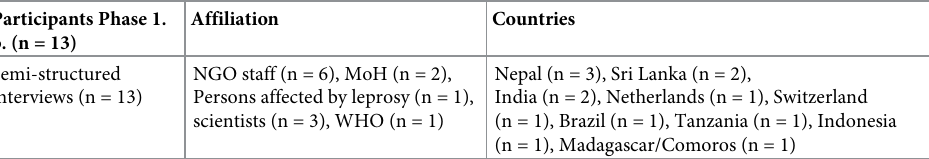
Table 1. Participants–Phase 1. Participants Phase 1. b. (n =